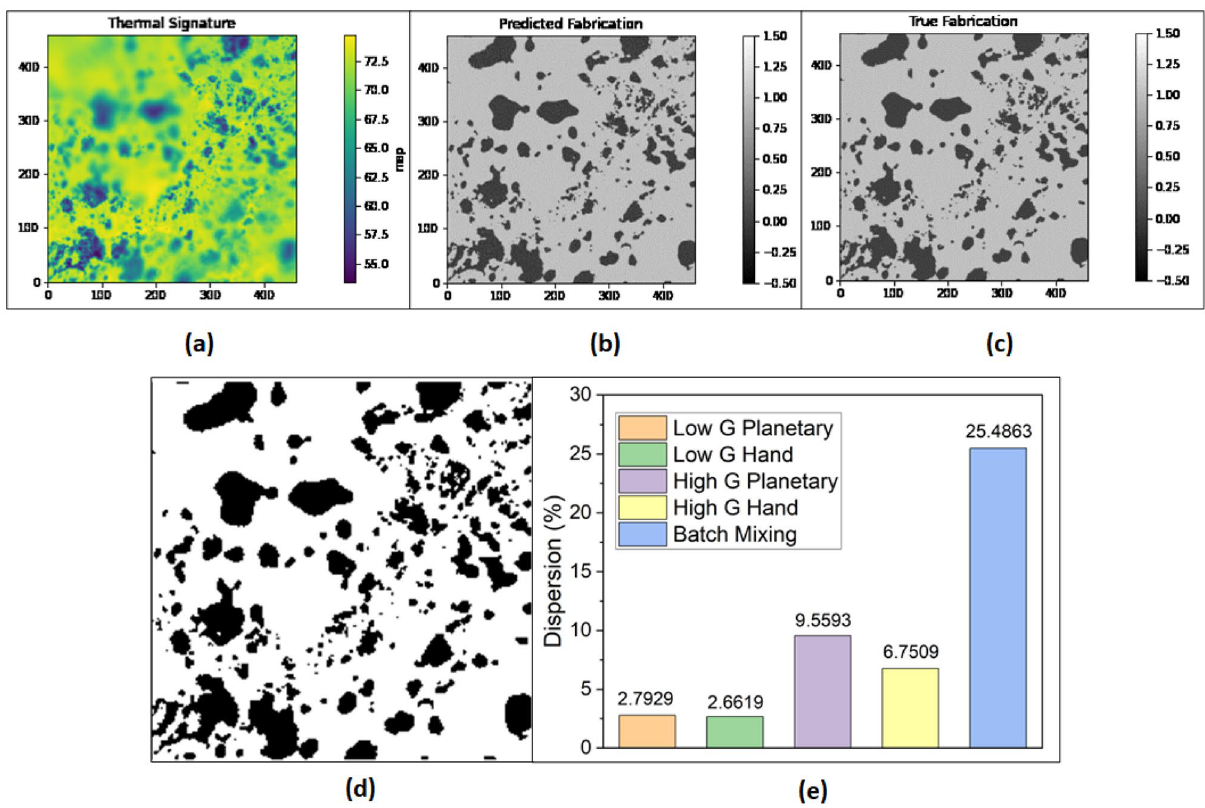
Figure 4. ( a ) Thermal image obtained for 40% G Batch mixing (out of focus at the top left corner), ( b – d ) corresponding predicted image, true and binary image obtained via machine learning and image processing (removed the blurriness due to out of focus) of the thermal image in ( a ), ( e ) Dispersion (%) of different mixing process calculated from the area pixels of the determined the dispersion by dividing the area into 4 squares. Figure 5d depicts the dispersion index with error bars for each of the samples. The mean dispersion index for hand, planetary, and batch mixing (whole sample) were 0.163, 0.0865, and 0.07, respectively. However, the hand mixing sample showed a wide range of dispersion at different position, and for planetary sample showed a dispersion index 0.04–0.10. Batch mixing sample depicts a narrower range in dispersion index meaning the dispersion of the fillers are nearly same (homogenous) in all over the composite. This ensures that batch mixing outperforms planetary in terms of filler homogeneity, while planetary outperforms hand-mixing.